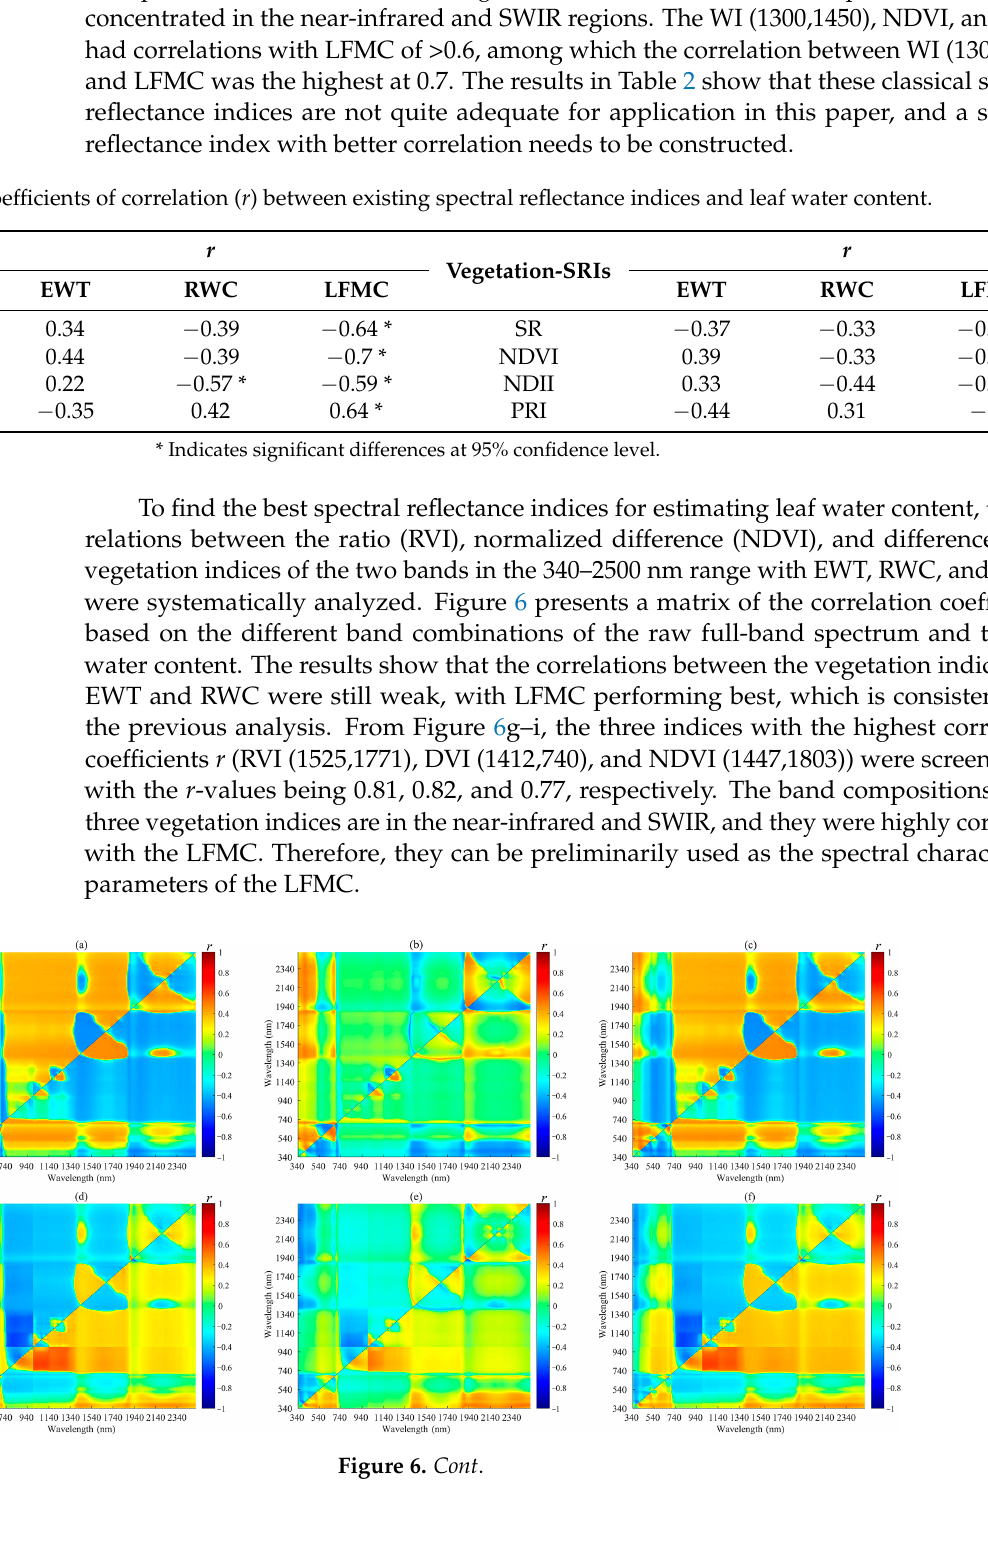
Figure 6. Coefficients of correlation between EWT, RWC, and LFMC with RVI ( λ 1, λ 2), NDVI ( λ 1, λ 2), DVI ( λ 1, λ 2), and ratio/normalized difference/difference vegetation indexes constructed from raw spectral data. ( a ) Correlation between EWT and RVI (RVI band combinations based on raw reflectance relationship with EWT); ( b ) Correlation between EWT and DVI; ( c ) Correlation between EWT and NDVI; ( d ) Correlation between RWC and RVI; ( e ) Correlation between RWC